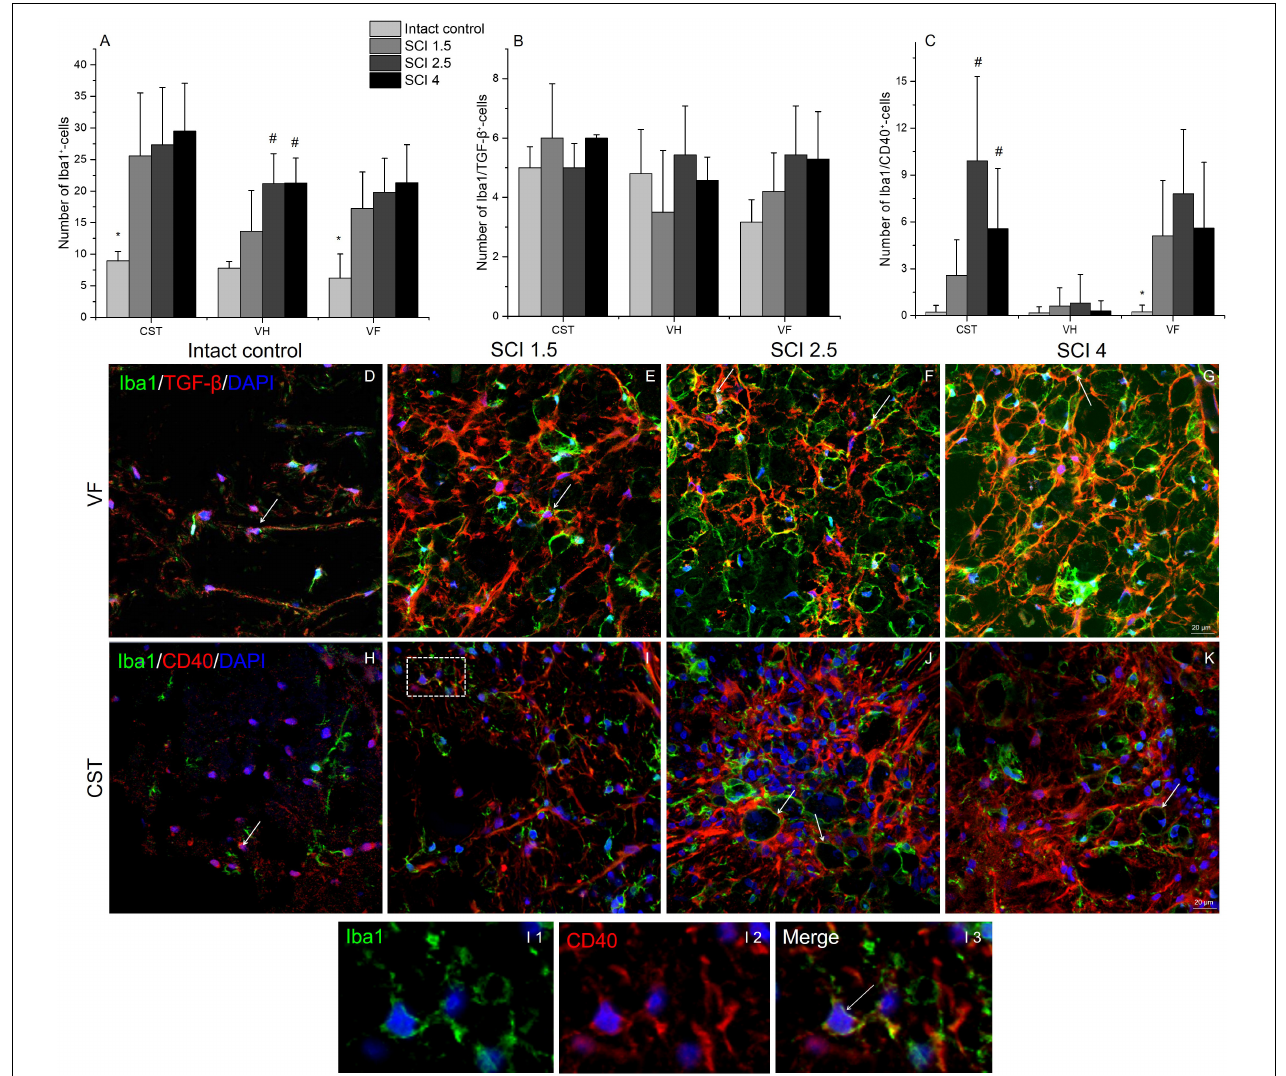
FIGURE 8 | Quantitative changes in CD40 and TGF- β expressing microglia populations. The number of Iba1 + (A) , Iba1 + /TGF- β + (B) , and Iba1 + /CD40 + cells (C) (Y-axis) in the examined regions (X-axis) of the intact spinal cord and experimental groups with spinal cord injury of mild (SCI 1.5), moderate (SCI 2.5), and severe (SCI 4) severities ( n = 8 in each group). Visualization of different microglia populations using Iba1 (green), TGF- β (red) or CD40 (red) 5 mm caudally from the injury epicenter (60 dpi) within the ventral funiculi (VF) and the main corticospinal tract (CST) in the investigated groups (D–K) . Iba1 + /TGF- β + and Iba1 + /CD40 + cells indicated by the arrow. All sections were imaged in the z-plane using identical confocal settings (laser intensity, gain, and offset). The I area marked with dashed boxes corresponds to enlarged images I1, I2, and I3. Nuclei are DAPI stained (blue). Scale bar: 20 µ m. *p < 0.05 as compared with all investigated groups; # p < 0.05 as compared with intact control, one-way ANOVA, followed by a Tukey’s post hoc test.